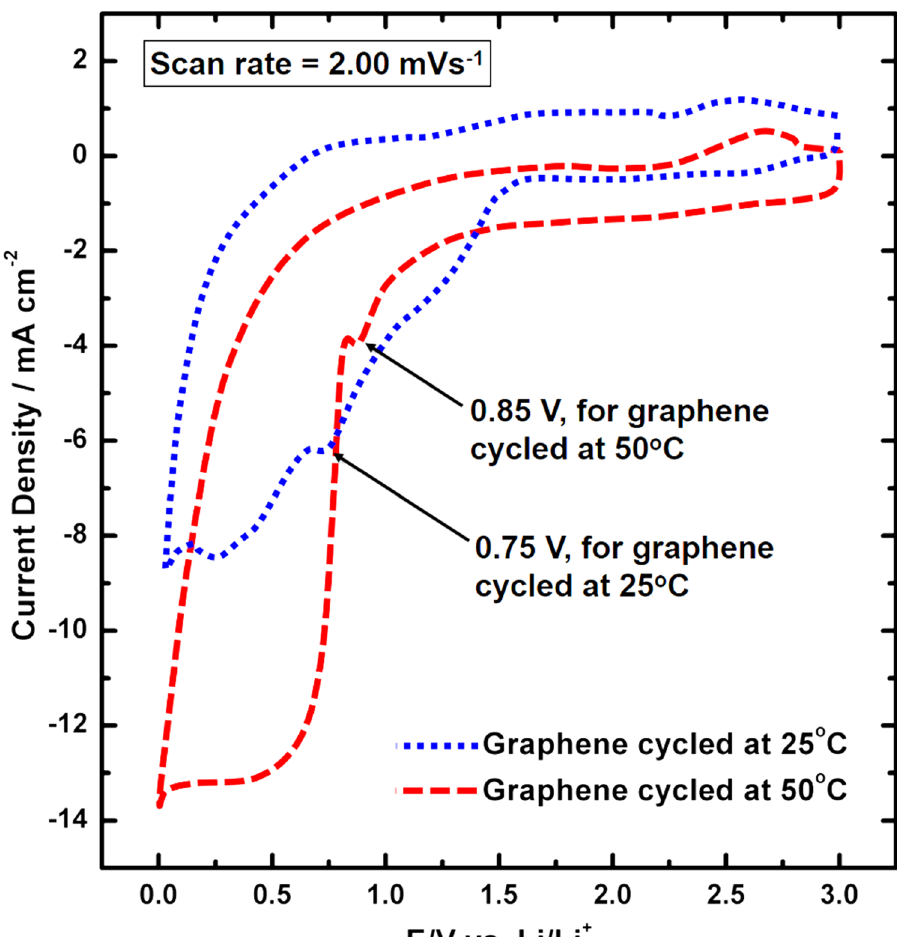
Fig. 7 Cyclic voltammograms obtained from graphene nanoflake-based anodes cycled at 25 and 50 °C using a voltage scan rate of 2.00 mV s